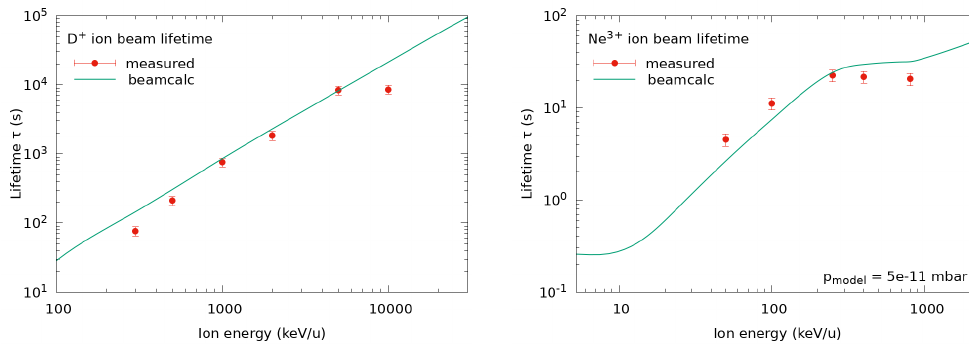
Figure 2. Energy-dependent ion beam lifetimes for D + ( left ) and Ne 3 + ( right ). Measured data (red dot symbols) are compared with our simple beamcalc model [15] (solid green